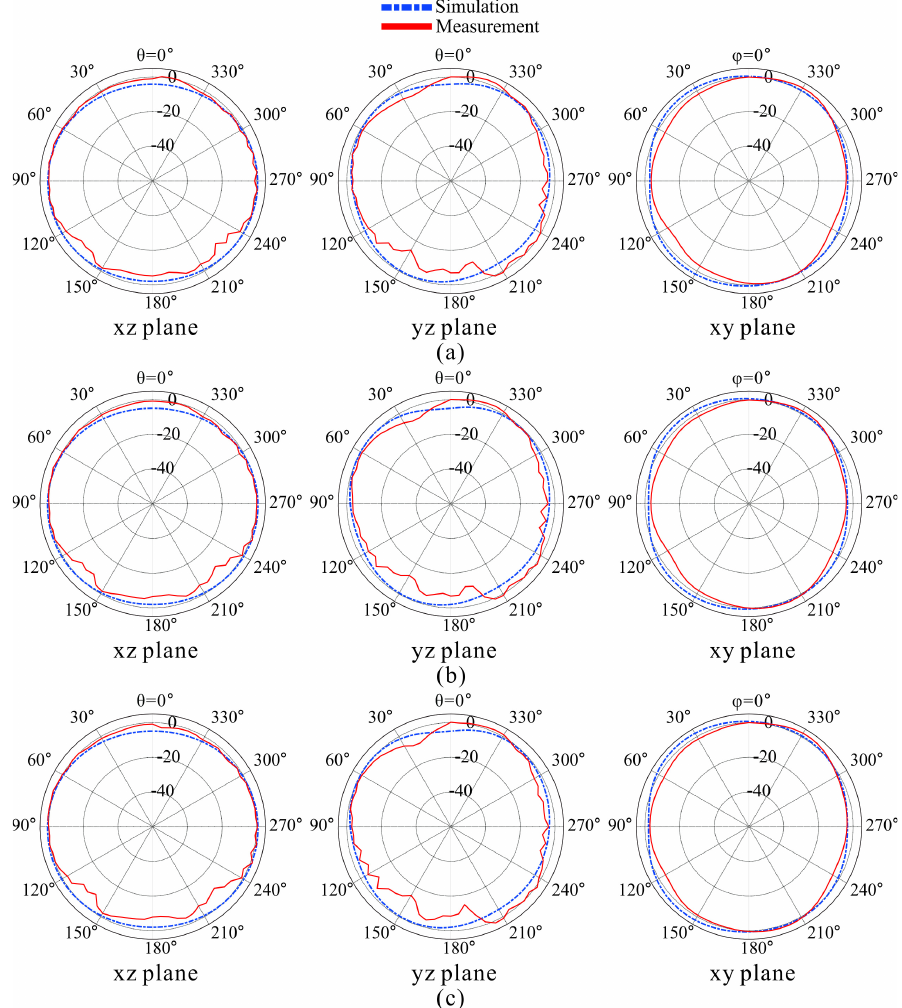
Figure 13. Comparison of simulated and measured radiation patterns of the proposed antenna: ( a ) 3.1, ( b ) 3.13, and ( c ) 3.15